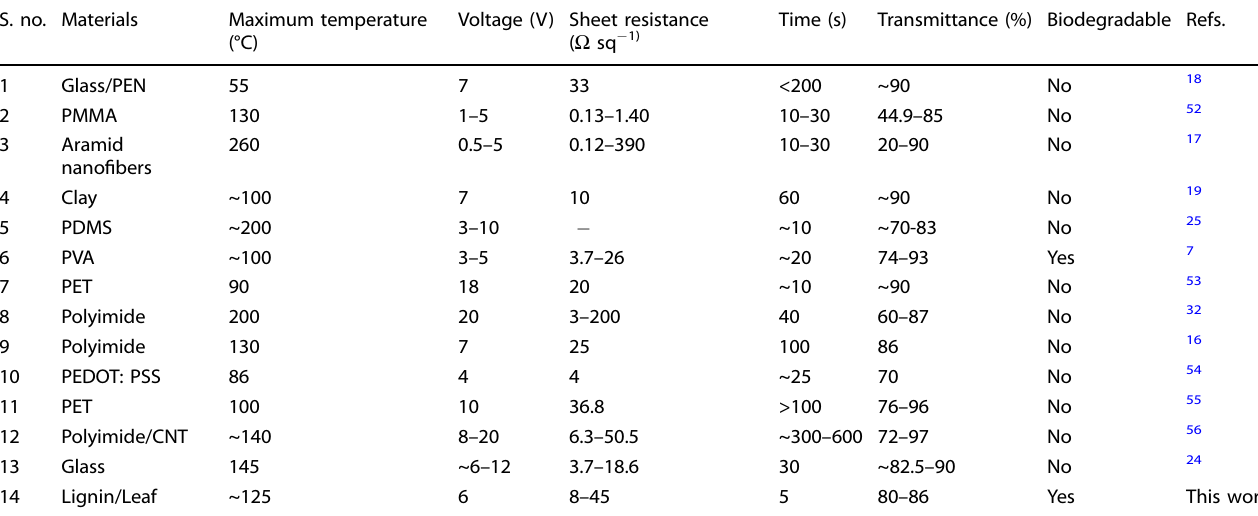
Table 1. Performance comparison in transparent heaters based on Ag